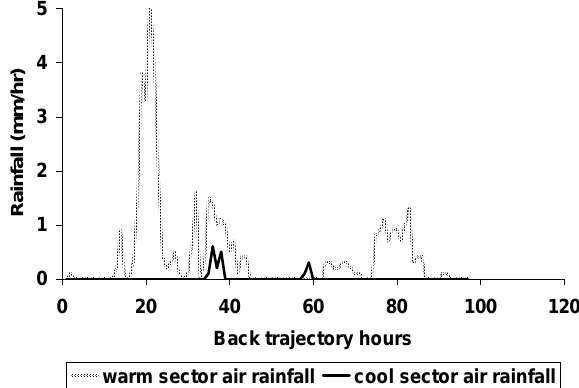
Fig. 4. NOAA HYSPLIT rainfall history for the back trajectories indicated in Fig. 3.